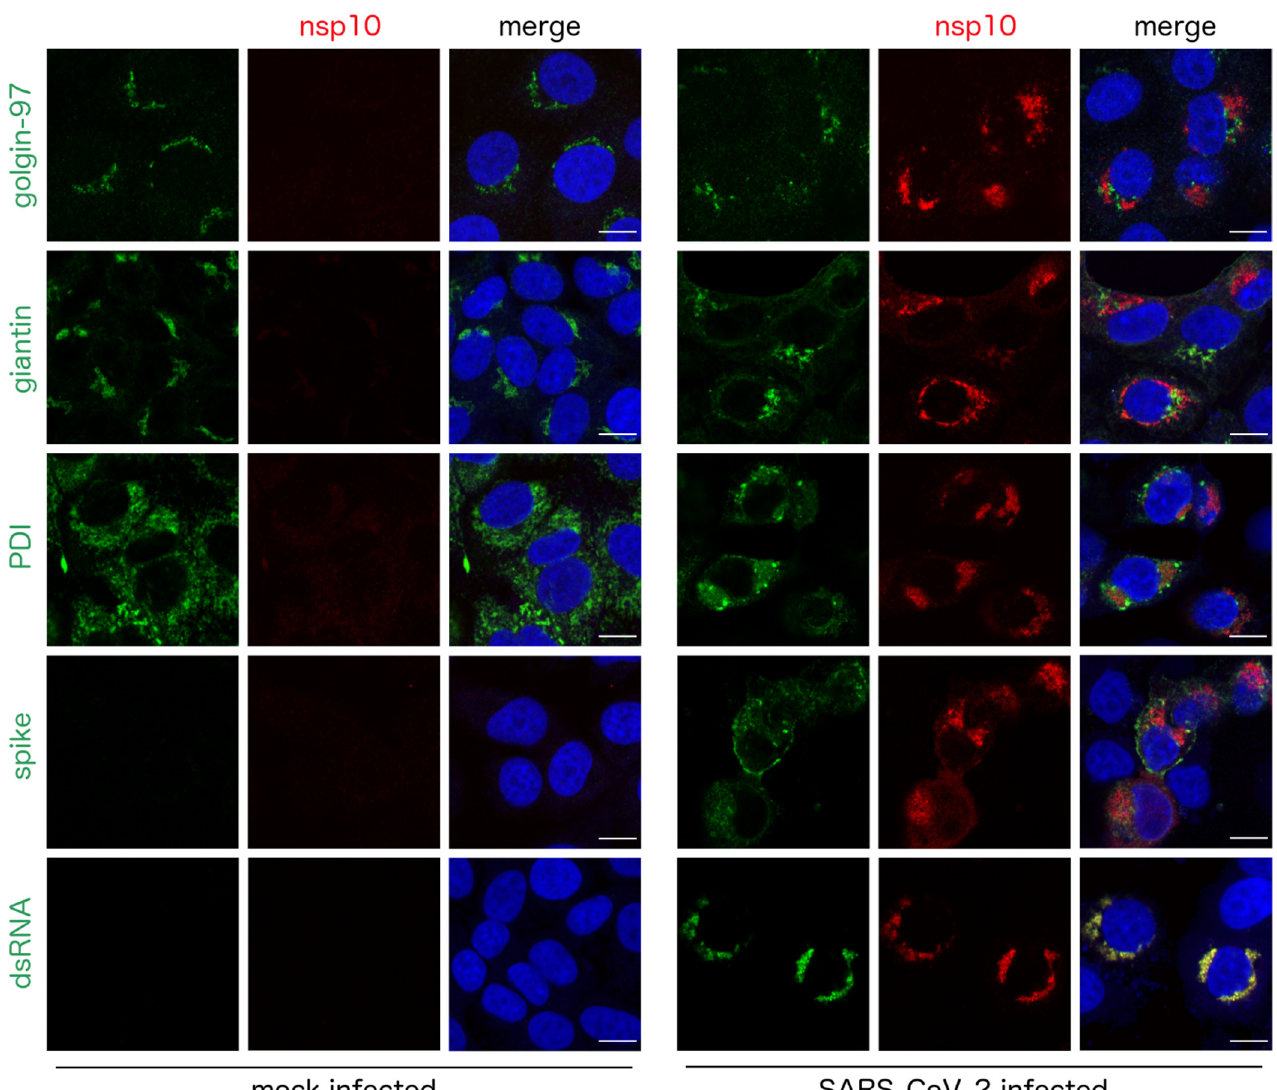
Figure 3. Subcellular localization of the nsp10 protein in the SARS-CoV-2-infected cells. Vero cells were infected with the SARS-CoV-2 strain hCoV-19/Czech Republic/NRL_6632_2/2020 , fixed at 36 h post infection and immunostained with antibodies as indicated. Subcellular localization of the nsp10 protein (red) and its co-localization with PDI (a marker of endoplasmic reticulum), giantin, golgin-97 (markers of Golgi), spike protein of SARS-CoV-2 and dsRNA (a marker of viral replication; green) were analyzed by confocal microscopy. Nuclei were stained with Hoechst 33342 (blue). Scale bars represent 10 µm.